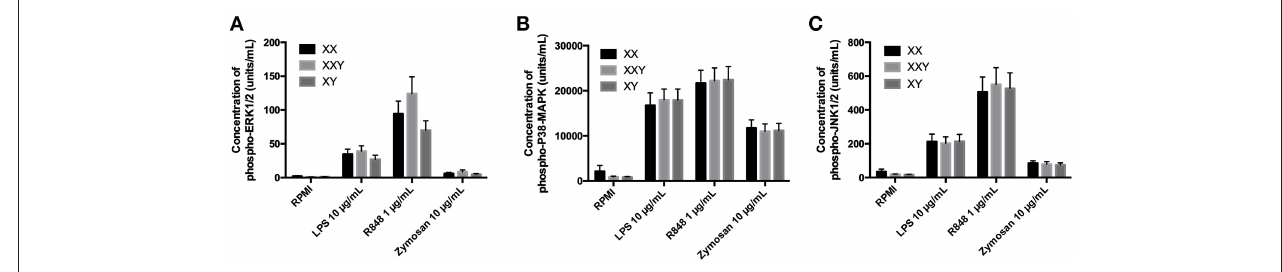
FIGURE 4 | Mean ± SEM of phospho-ERK1/2 (A) , phospho-P38-MAPK (B) , and phospho-JNK1/2 (C) concentrations in purified monocytes after stimulation with LPS 10 µ g/mL, resiquimod 1 µ g/mL and zymosan 10 µ g/mL in men, women, and subjects with Klinefelter syndrome. Purified monocytes resuspended at 10 × 10 6 cells/mL in culture medium were incubated with the ligand for 15min. Concentrations of the phosphorylated kinases were measured in the cell lysate by flow cytometry. BD FACSDiva TM software version 6.1.2 for Windows was used to acquire the data and BD FCAP Array TM software version 1.0.1 for Windows was used to analyze the data.